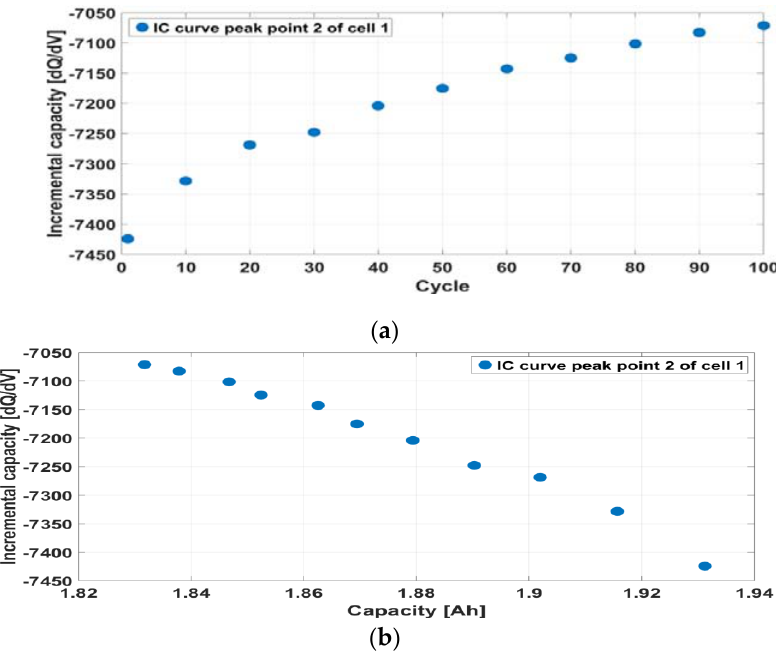
Figure 11. IC variation with respect to the cycle and discharge capacity at IC curve valley point 1 according to the aging cycle test (no. 1 cell): ( a ) cycle and ( b ) discharge capacity.